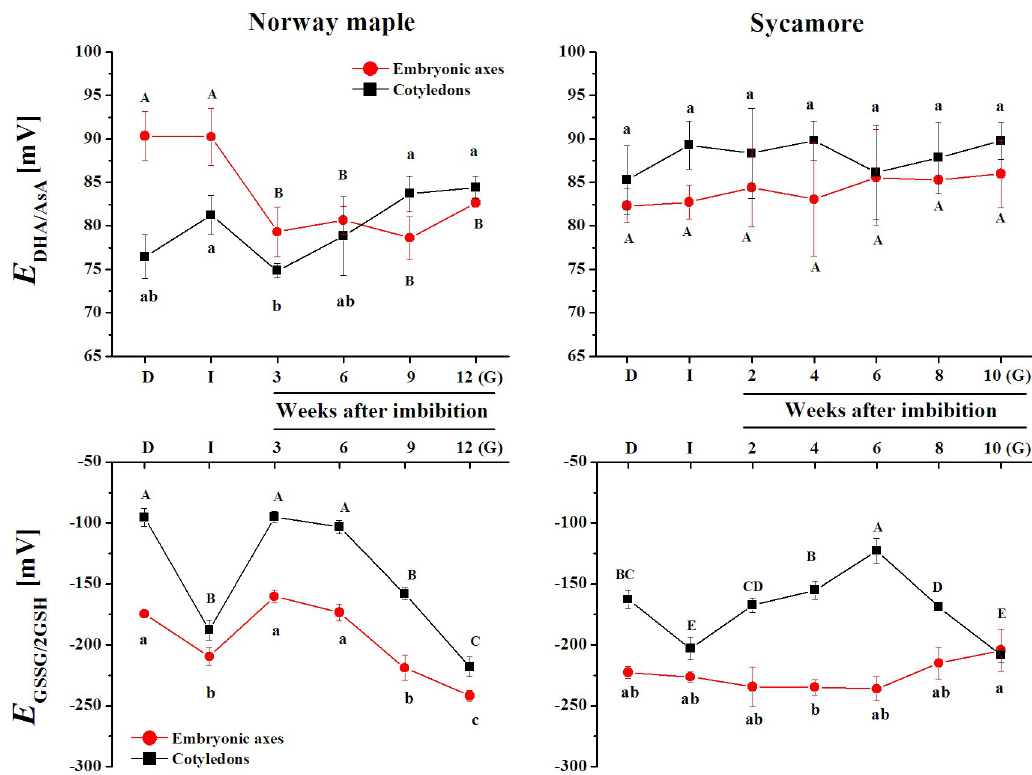
Fig 7. Changes in the levels of the half-cell reduction potential of glutathione ( E GSSG/2GSH ) and ascorbate ( E DHA/AsA ) reported in the embryonic axes and cotyledons of dry and germinating Norway maple and sycamore seeds. (D) Dry seeds; (I) Imbibed seeds; (G) Germinated seeds. Data are the means of three independent replicates ± std. Statistically significant differences are indicated with different letters (one-way ANOVA, followed by Tukey’s test at p < 0.05).